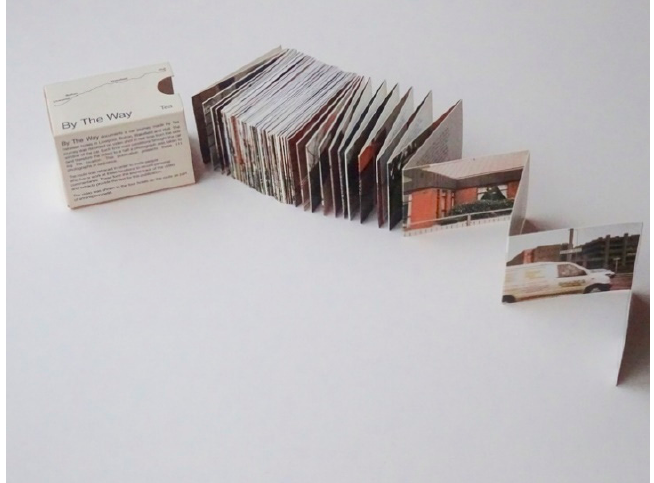
Figure 3. By The Way (1999) by Those Environmental Artists (TEA). Photo by Charles Quick.